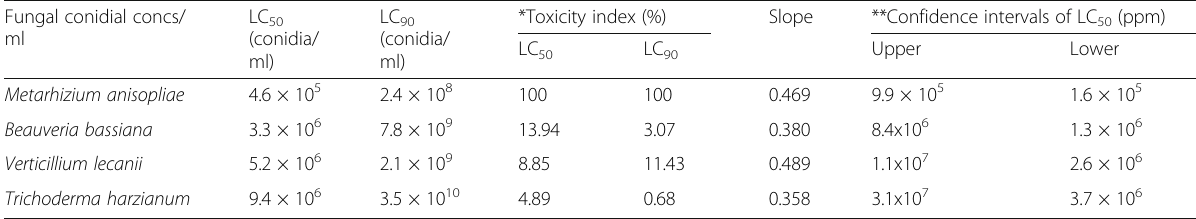
Table 1 Virulence of isolates of the Metarhizium anisopliae , Beauveria bassiana , Verticillium lecanii , and Trichoderma harzianum towards the two-spotted spider mite, Tetranychus urticae Fungal conidial concs/ ml